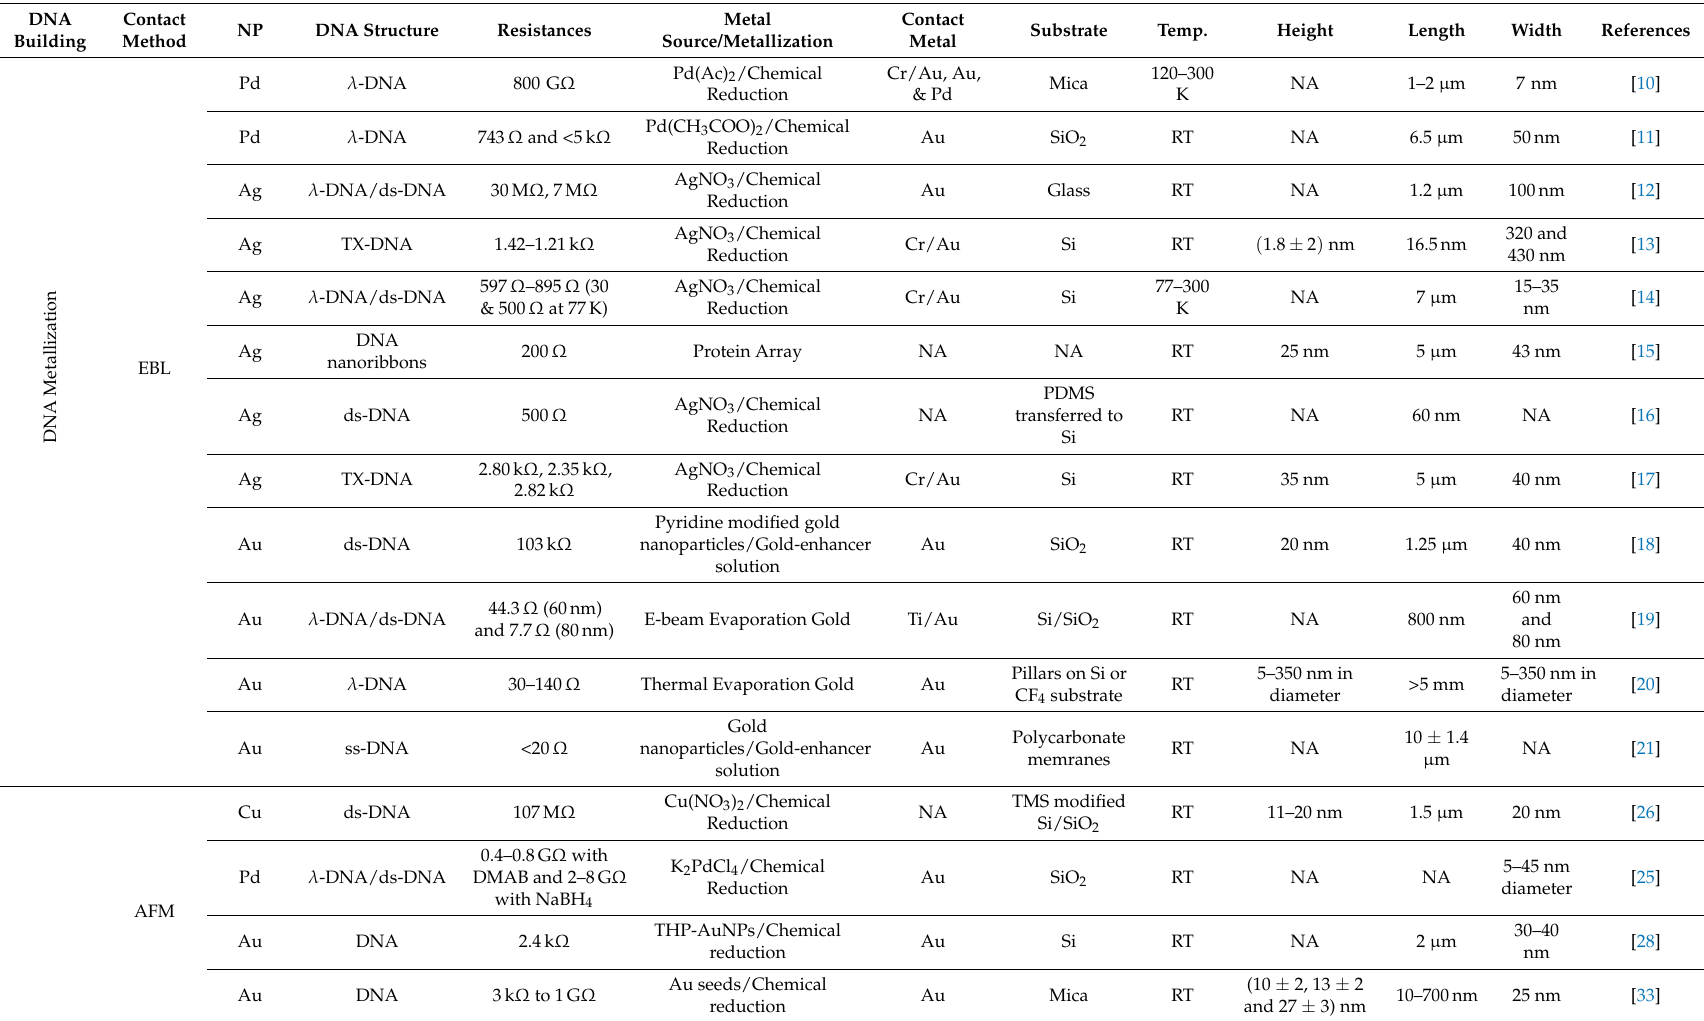
Table 1. Summary of resistance values and construction properties of DNA templated metal